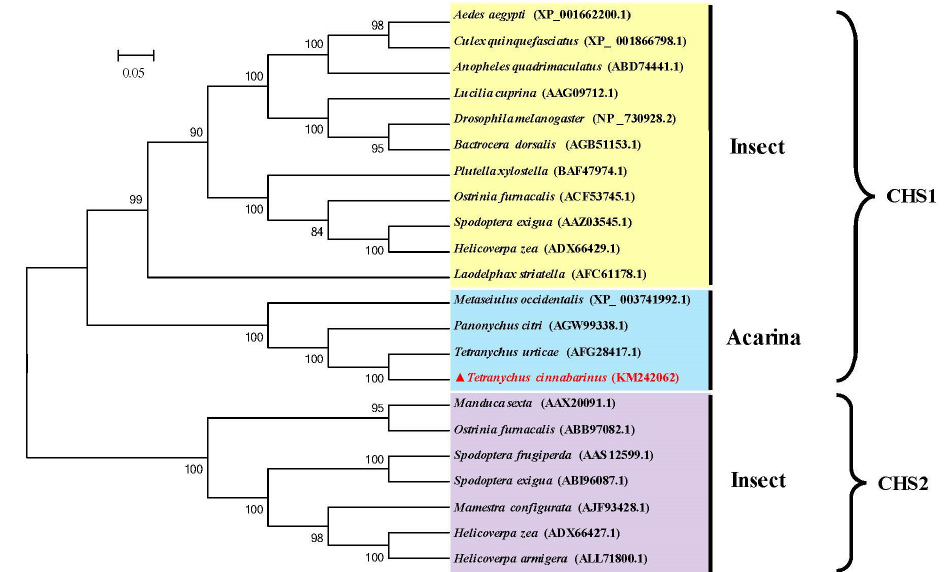
Figure 3. Phylogenetic relationships of chitin synthase of T. cinnabarinus with those of other arthropod species based on the deduced amino acid sequences alignment. The phylogenetic tree was generated by MEGA 5.05 using the maximum likelihood (ML) method. Numbers above the branches are bootstrap support values. The completely assembled and annotated TcCHS1 sequence was deposited in the National Center for Biotechnology Information (NCBI) GenBank under accession number KM242062. Sequences were taken from GenBank database (GenBank accession number in parentheses). TcCHS1 , Tetranychus cinnabarinus (KM242062); TuCHS1 , Tetranyus urticae (AFG28417.1); PcCHS1 , Panonychus citri (AGW99338.1); MeCHS1 , Metaseiulus occidentalis (XP-003741992.1); AaCHS1 , Aedes aegypti (XP-00166200.1); CqCHS1 , Culex qinguefasciatus (XP-001866798.1); AqCHS1 , Anopheles quadrimscalatus (ABD74441.1); LcCHS1 , Lucilia cuprina (AAG09712.1); DmCHS1 , Drosophila melanogaster (NP-730928.2); BdCHS1 , Bactrocera dosalis (AGB51153.1); PxCHS1 , Plutella xylostella